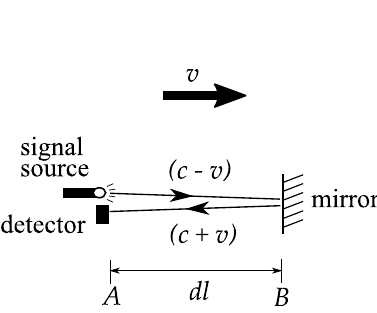
Fig. 3. A rod AB with rest length dl , moving with velocity v , and aligned along the orientation of motion. A comoving observer is measuring the rod by timing the round-trip signal sent from one end of the rod to the other and vice versa. The situation is represented from the view point of a stationary